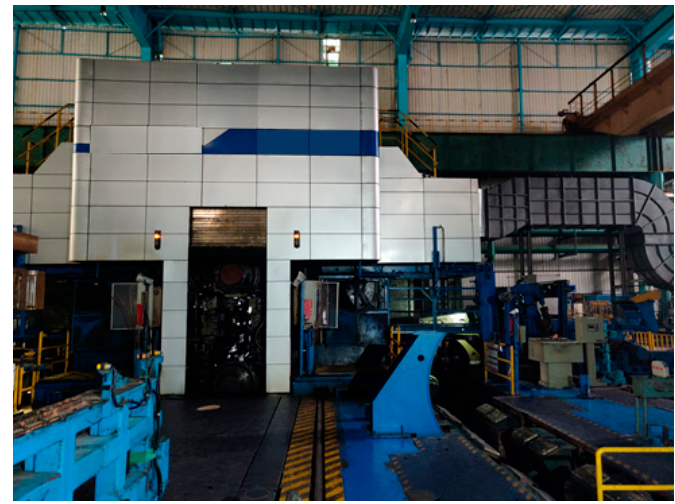
Figure 9. Schematic diagram of six-high reversible cold mill production.